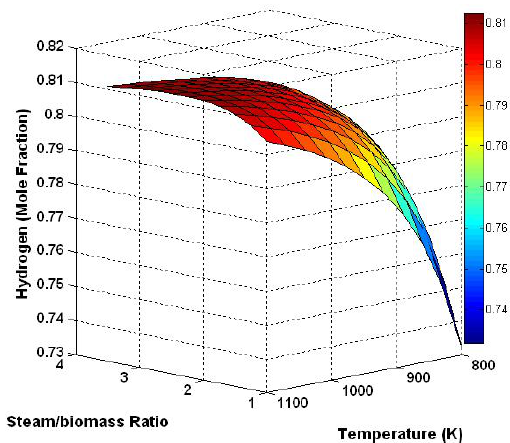
Figure 4. Surface plot of hydrogen for different temperatures and steam/biomass